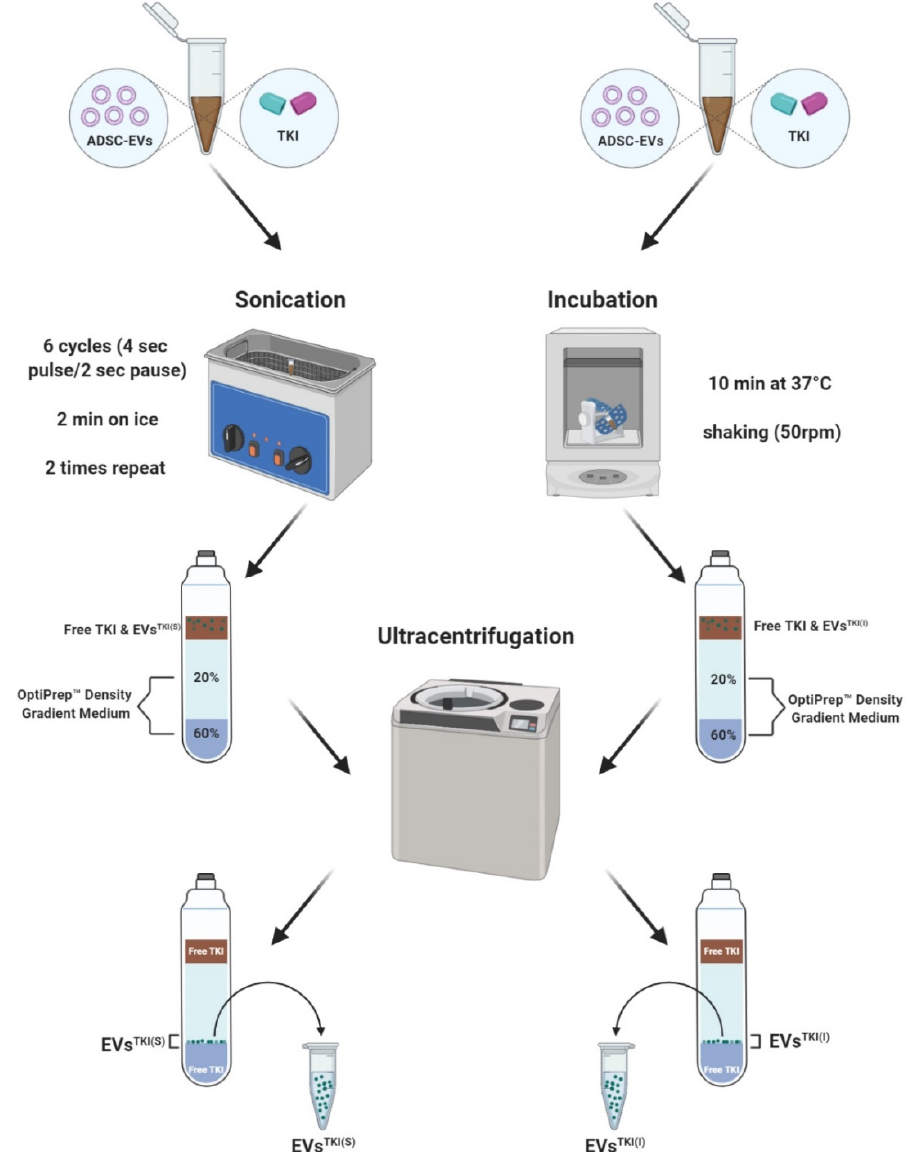
Figure 3. Illustration of the process used to load the TKI into the EVs. This illustration was created with BioRender.com software.